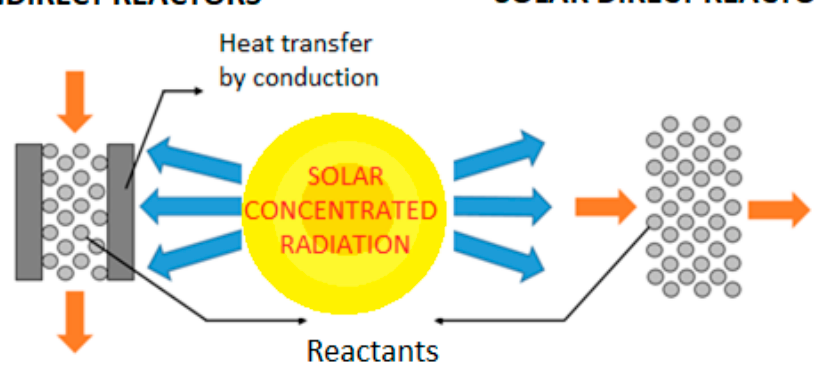
Figure 1. Conceptual sketch depicting indirect solar reactors (left) and direct solar reactors (right).